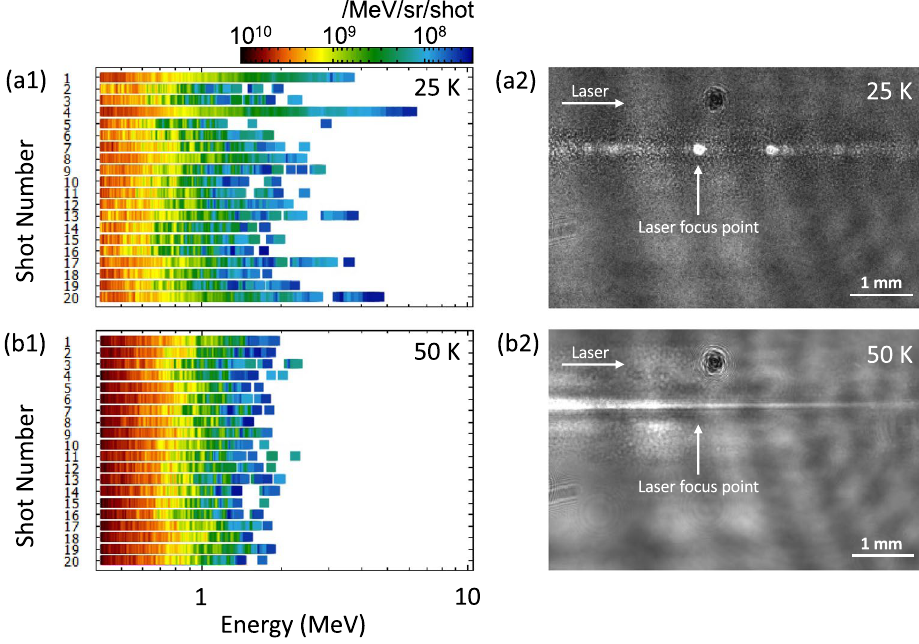
Figure 3. Shot-to-shot properties of laser-accelerated protons. Series of single-shot energy spectra for 20 consecutive shots measured using the real-time-type Thomson parabola ion detector at nozzle temperatures of ( a1 ) 25 K and ( b1 ) 50 K. The color scale displays the number of ions. The shadowgraph image of the laser propagation in the cluster gas flow with delay time at ∼ 100 ps at nozzle temperatures of ( a2 ) 25 K and ( b2 ) 50